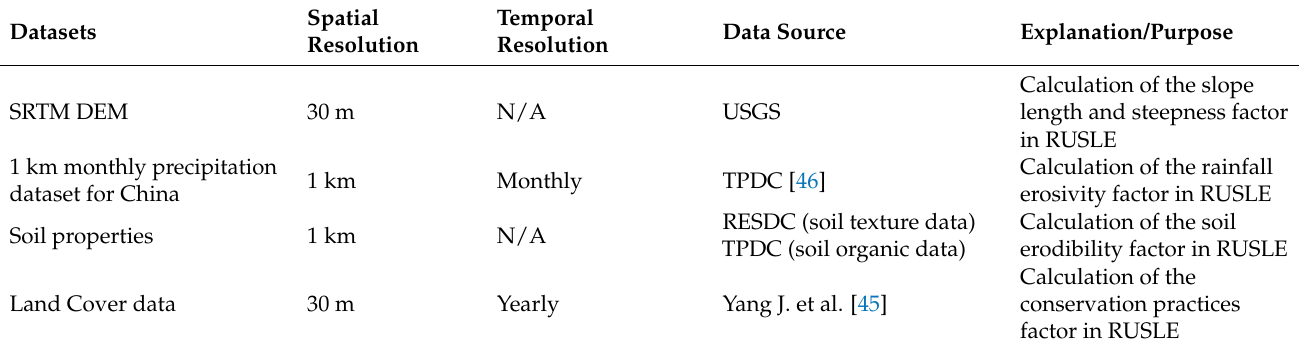
Table 1. Data sources and